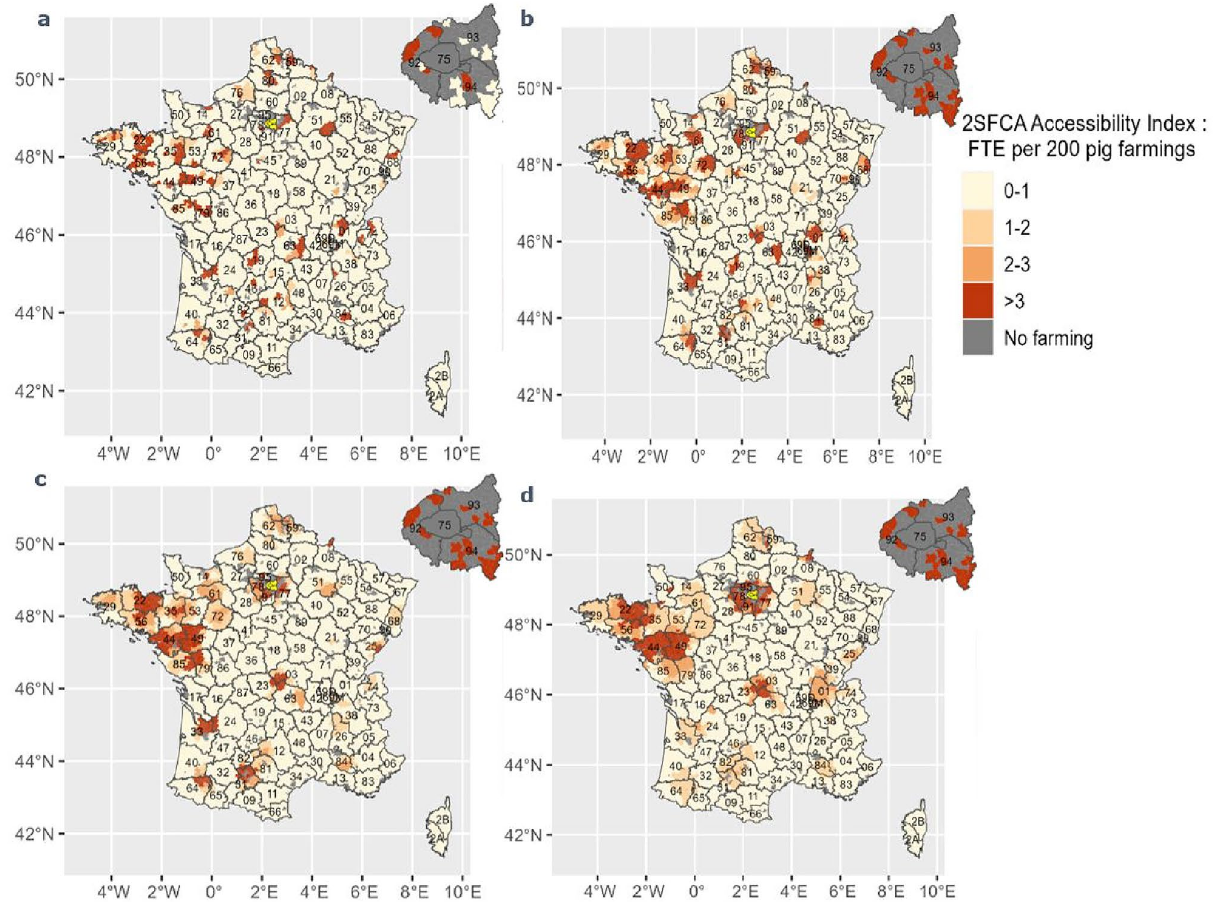
Figure 2. Spatial accessibility of the swine sector to veterinarians in France for various travel time